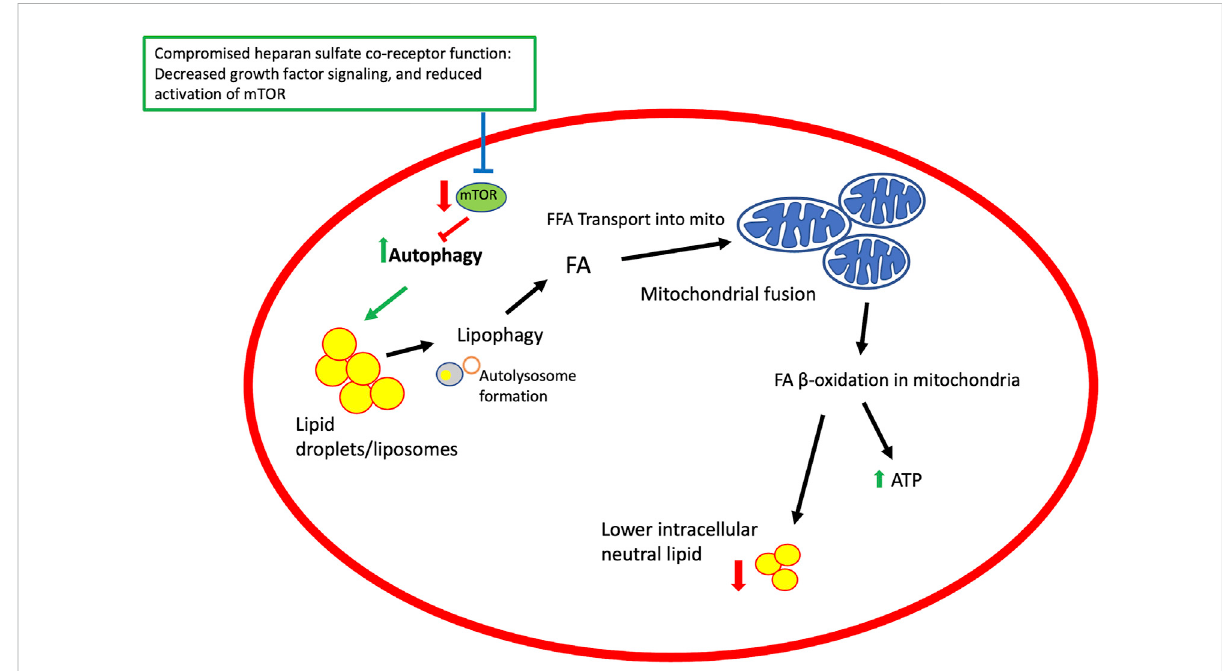
FIGURE 3 A model for heparan sulfate proteoglycan co-receptor function affecting autophagy, lipid metabolism and mitochondrial function. Growth factorsignalingmodulatedbyHSPGsaffectsignalingpathwaysthatregulatemTORactivity.TORisaninhibitorofautophagyandthuscompromising mTORactivationpromotesautophagyanddownstreamevents,includinglipophagyandmobilizationoffattyacidsfromlipiddroplets,mitochondrial fusion, and β -oxidation of lipids in mitochondria to generate ATP and lower intracellular lipid stores. Elements of this fi gure re fl ect events summarized in a published review (Hsu et al.,